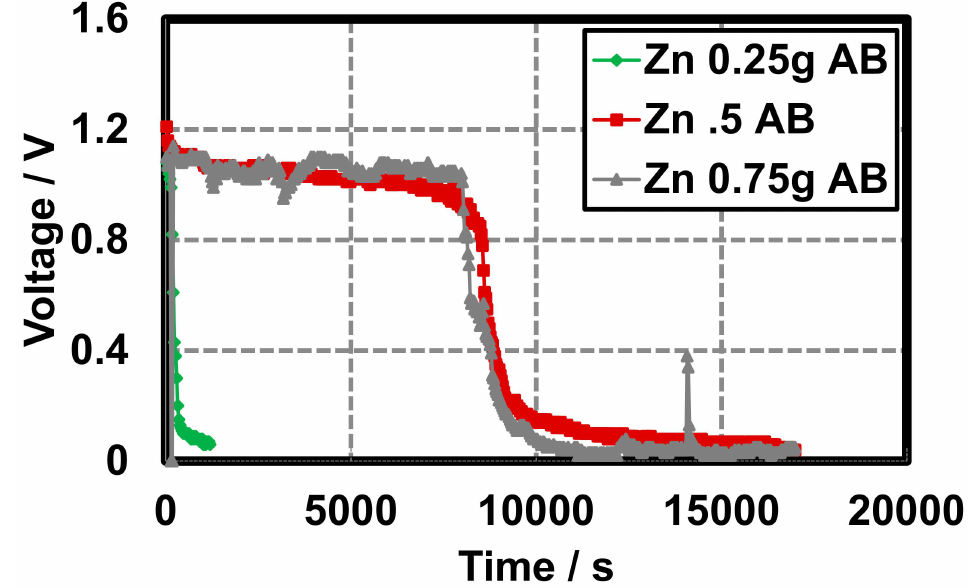
Figure 6. Gel Leclanch é cell continuous discharge data across a 10 k Ω resistor, with AB as the conductive additive, 0.5 g MnO 2 , and variable zinc: 0.25 g ( ), 0.5 g ( ), and 0.75 g (